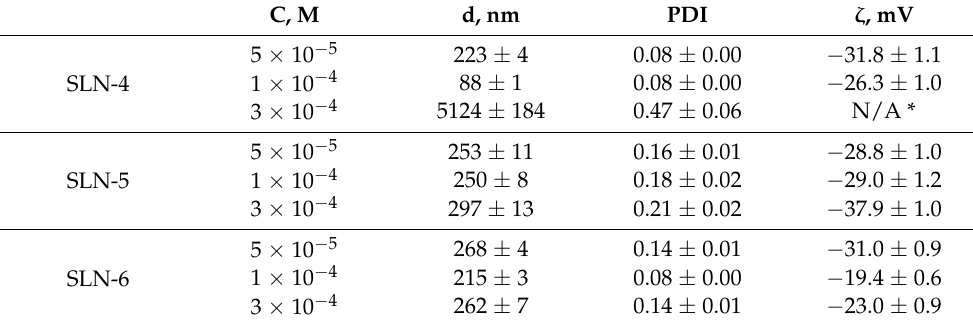
Table 1. Physicochemical characteristic of SLN in water: d—hydrodynamic diameter by the dynamic light scattering (DLS) method, PDI—polydispersity index, ζ —zeta potential.